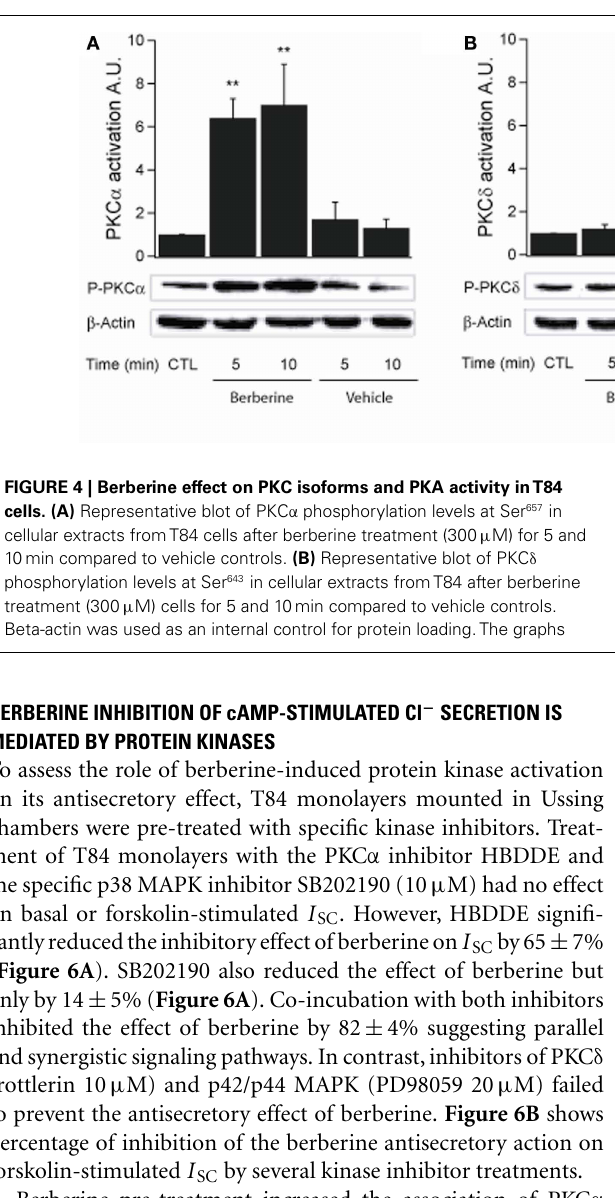
represent densitometric analysis of PKC blots or PKA activity assays.Values are given as fold changes in PKC phosphorylation (activation) or PKA activity respect to an untreated control.Values are displayed as mean ± SEM ( n = 3 for each group, ** P < 0.01). (C) Representative blot of PKA phosphorylation levels in cellular extracts fromT84 after berberine treatment (300 μM) cells for 10 min compared to vehicle controls and cells pretreated for 10 min with 100 μM HBDDE, a selective PKC α